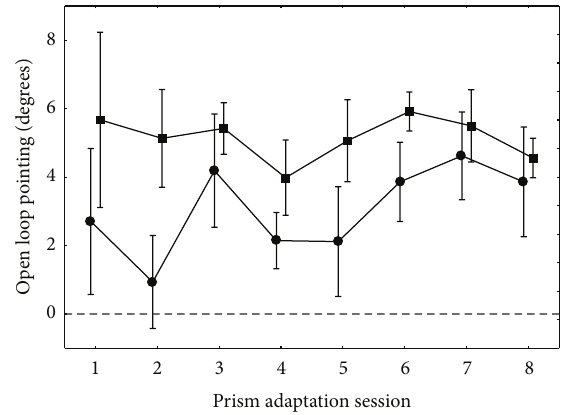
Figure 5: Open loop pointing ( ± SEM) for the adapted hand throughout the prism rehabilitation period. This figure displays preadaptative (circles) and postadaptative (squares) values of open loop pointing movements performed with the adapted hand toward a visual target. The difference between the two curves shows that every session gave rise to the expected compensatory aftereffects. Although the posttest seemed to remain fairly stable over time, indicating that a maximal shift in OLP was obtained from the first session, the gradual shift of the pretest values suggested that some retention of aftereffects was gained and capitalized between each session. Therefore, the apparent size of aftereffects appears to reduce with time, even if the ANOVA interaction between session and the pre-post effect did not reach